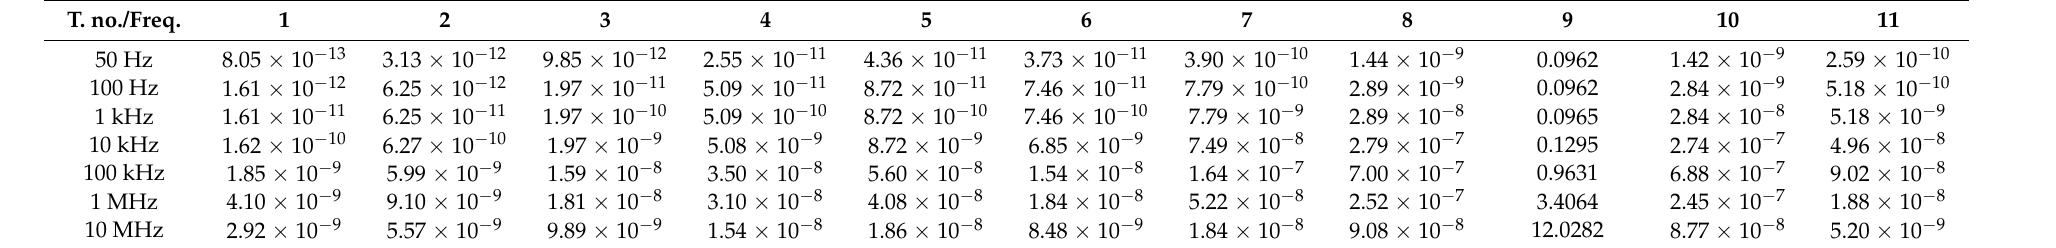
Table A18. Self and mutual resistances of turn 9 (in Ω ) resulting from FEM simulations. T. no./Freq.